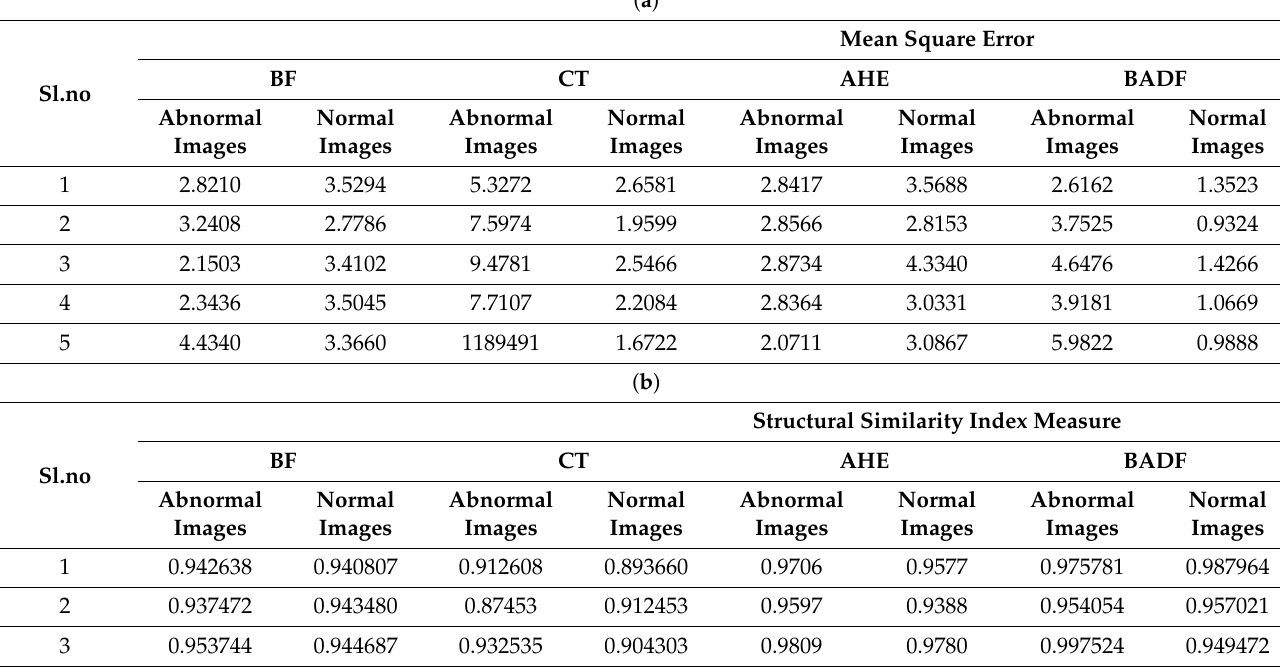
Table 4. ( a ) Gives the mean square error for various filters in five abnormal and normal images. ( b ) Gives the structural similarity index measure for various filters in five images of abnormal and normal. ( c ) The signal-to-noise ratios for various filters in five abnormal and normal images are tabulated as